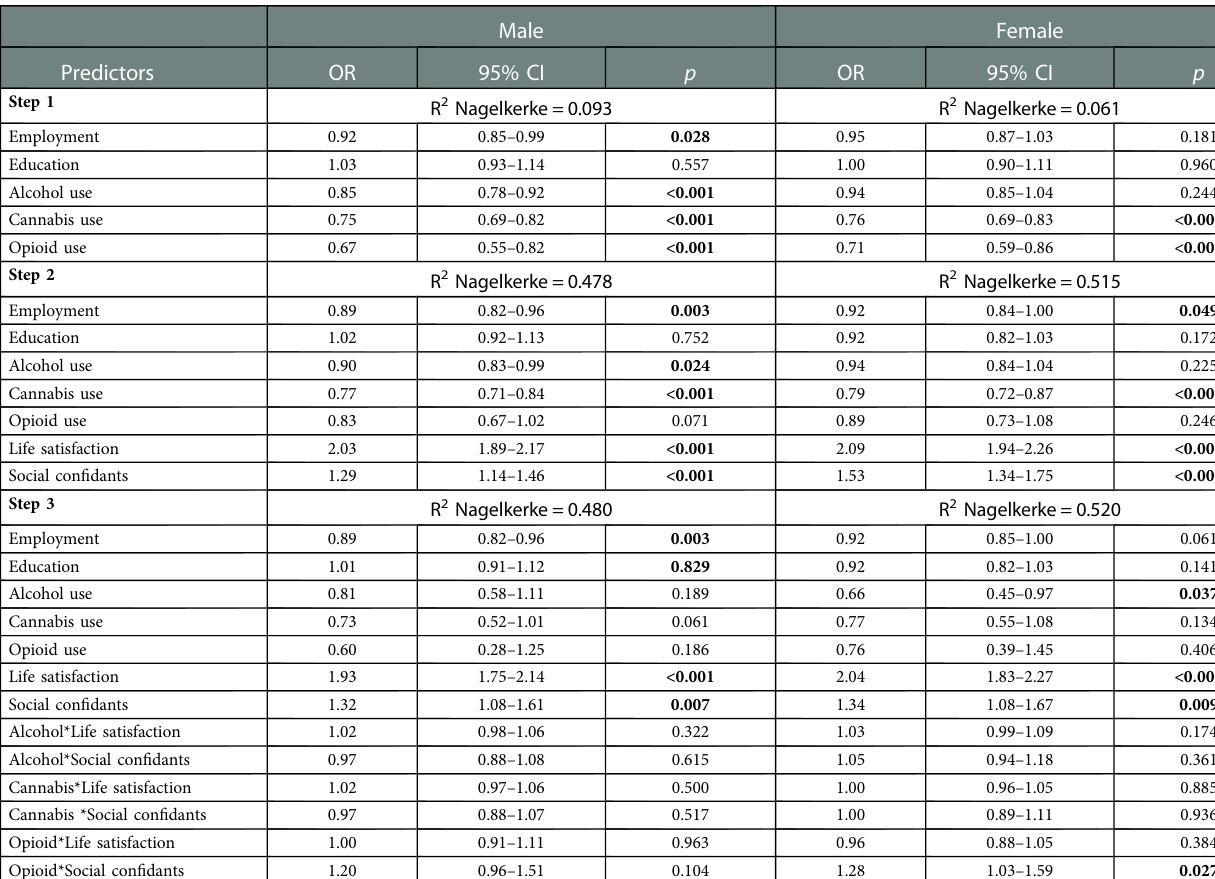
TABLE 3 Regression model for people reporting high feelings of shame towards substance us